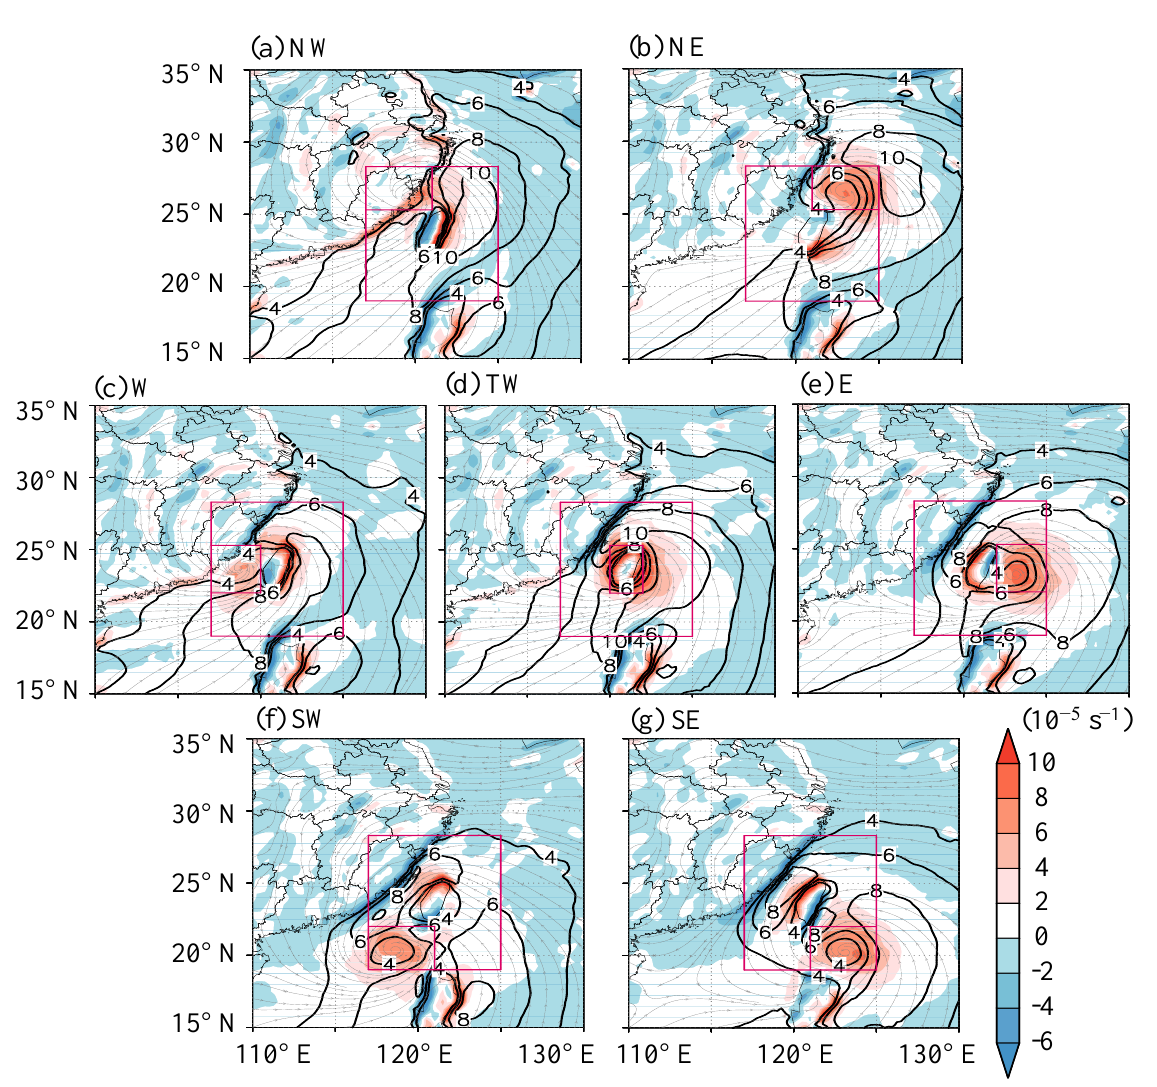
Figure 3. Composite vertical vorticity (shading, units: 10 −5 s −1 ), wind speed (black contours, units: m s −1 ), and streamlines (gray lines) at 10-m height for TCs in subregions: ( a ) NW, ( b ) NE, ( c ) W, ( d ) TW, ( e ) E, ( f ) SW, and ( g ) SE. Here and in Figure 4, the outer box indicates the study region and the nested box indicates the composite subregion.